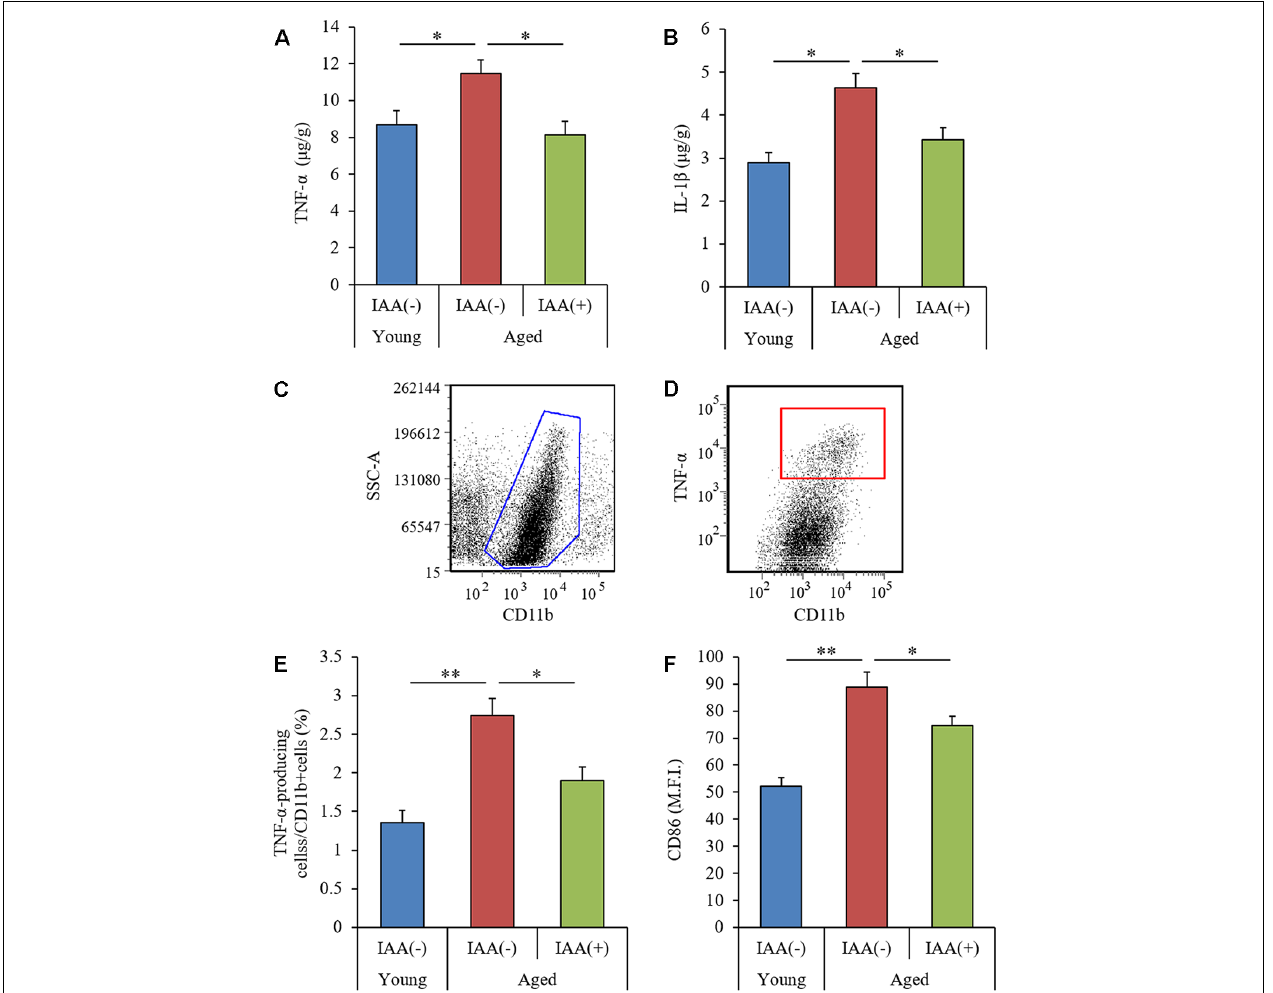
FIGURE 2 | Characteristics of microglial inflammation in aged mice. We fed C57BL/6J mice aged 7 weeks (young) and 68 weeks (aged) diets containing 0% or 0.05% (w/w) IAA for 3 months. We then obtained brain tissue for the analysis of microglial inflammation from young mice ( n = 12) and aged mice with ( n = 10) or without ( n = 9) dietary IAA. (A,B) The levels of TNF- α (A) and IL-1 β (B) in the hippocampus. (C,D) Flow cytometry characterization of TNF- α -production in CD11b-positive microglia isolated with magnetic cell sorting. (E,F) We collected CD11b-positive microglia using magnetic cell sorting and analyzed them using a flow cytometer, examining the ratio of TNF- α -producing cells to CD11b-positive cells (E) and the expression of CD86 on CD11b-positive cells (F) . Data are presented as mean ± SE. We calculated p -values shown in the graph by one-way ANOVA, followed by the Tukey-Kramer test. ∗ p < 0.05 and ∗∗ p < 0.01.